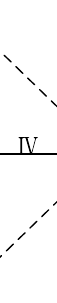
Fig. 1 Zone division of apparent impedance